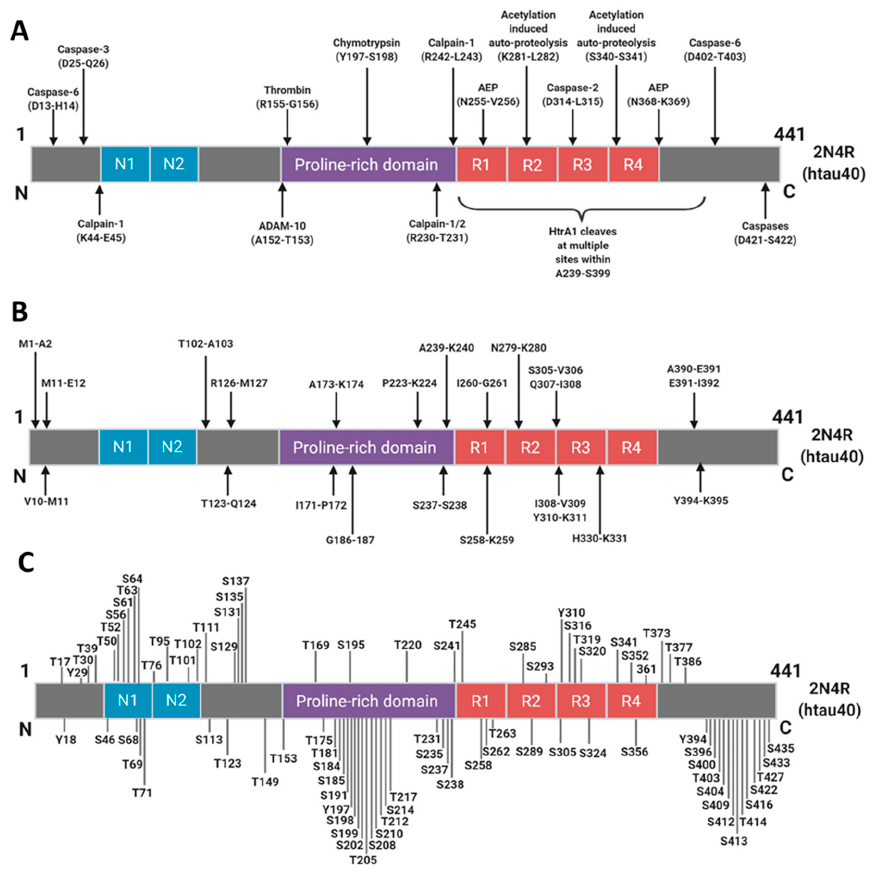
Figure 6. Sites for truncation and phosphorylation of human tau (2N4R): Proteolytic cleavage sites where known proteases are responsible ( A ) or where the protease responsible has yet to be identi- fi ed ( B ). Putative tau phosphorylation sites ( C ). Those below each of the 2N4R tau schematics are sites that have been identi fi ed in the AD brain. Information derived from [46]. Reprinted from [47]. Copyright (2018) IOS Press and authors under terms of CC BY-NC